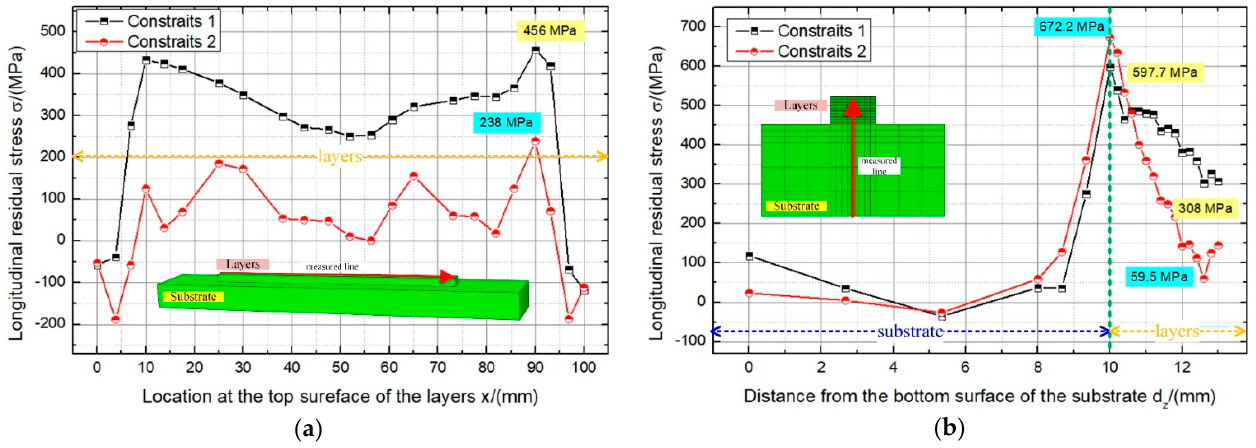
Figure 9. Longitudinal residual stresses with different constraints on the substrate: ( a ) on the top surface of the layers; ( b ) in the vertical middle section.